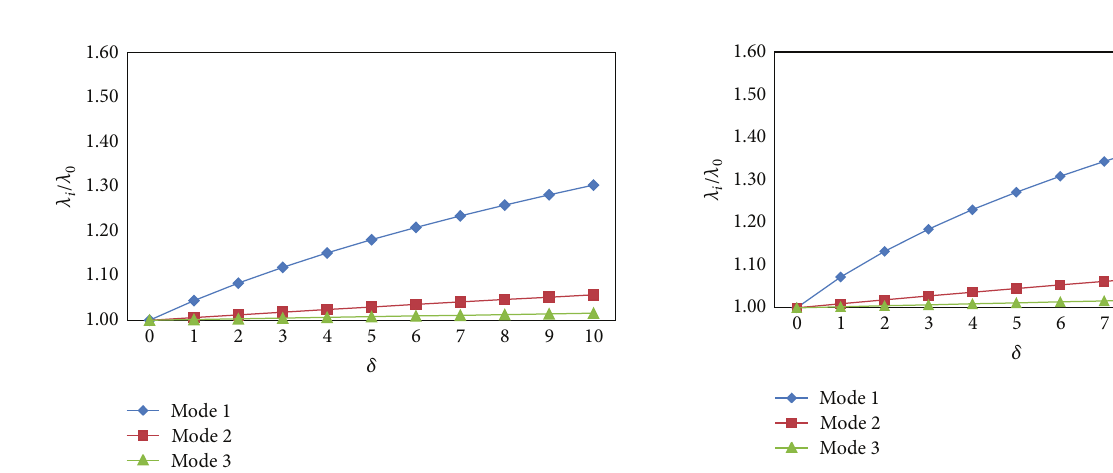
the elastic foundation parameter ( 𝛿 ) result in a significant change in the vibration frequencies (see Figure 3). For the case in hand, changing the elastic foundation parameter ( 𝛿 ) from 0 to 10 results in an increase in the first mode of about 30 percent, whereas second and third modes are not much affected from the existence of the elastic foundation parameter, as can be noted from the